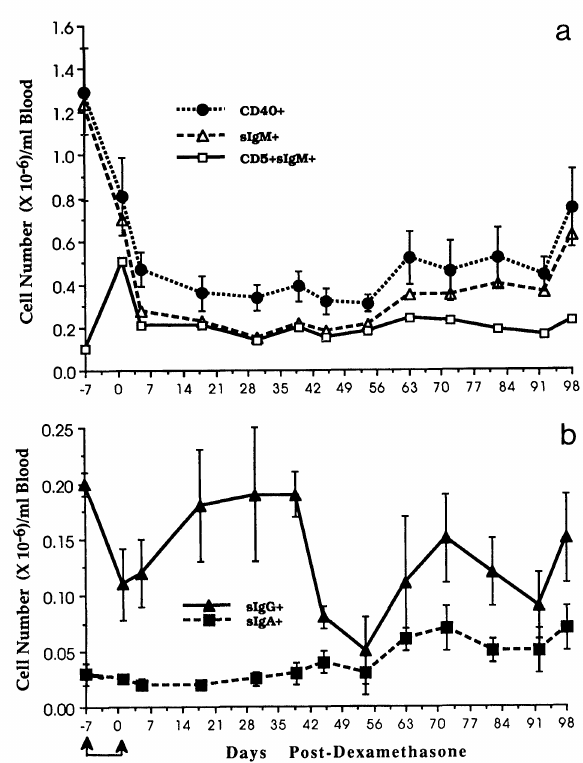
FIGURE 9. There was a sharp decline in total B-cell numbers in blood following dexamethasone treatment (2 mg/kg for 7 days) and this B lymphopenia persisted throughout the experiment, a: One week following dexamethasone treatment, the total number of B-cells (CD40 /) in blood had declined to 30% of pretreatment values. The sIgM B-cells (sIgM accounted for 90% of B-cells in blood prior to dexamethasone treatment, but less than 50% follow- ing dexamethasone treatment. Finally, CD5 sIgM B-cells (CD5 sIgM were a minor population in young lambs, but more than 90% sIgM B-cells expressed a detectable level of CD5 fol- lowing dexamethasone treatment. A detectable level of CD5- sIgM B-cells were apparent 80 days posttreatment and then grad- ually increased, b: Dexamethasone treatment did not significantly alter the number of sIgG B-cells (sIgG or sIgA B-cells (sIgA in blood. Considerable variation in isotype-switched B-cell number was noted within and among experimental groups. Following dex- amethasone treatment, the isotype-switched B-cells comprised 50% of the total B-cell population. Data presented are the mean + S.D. of values from varying numbers of lambs (days -7 and 0: n 16; day 98: